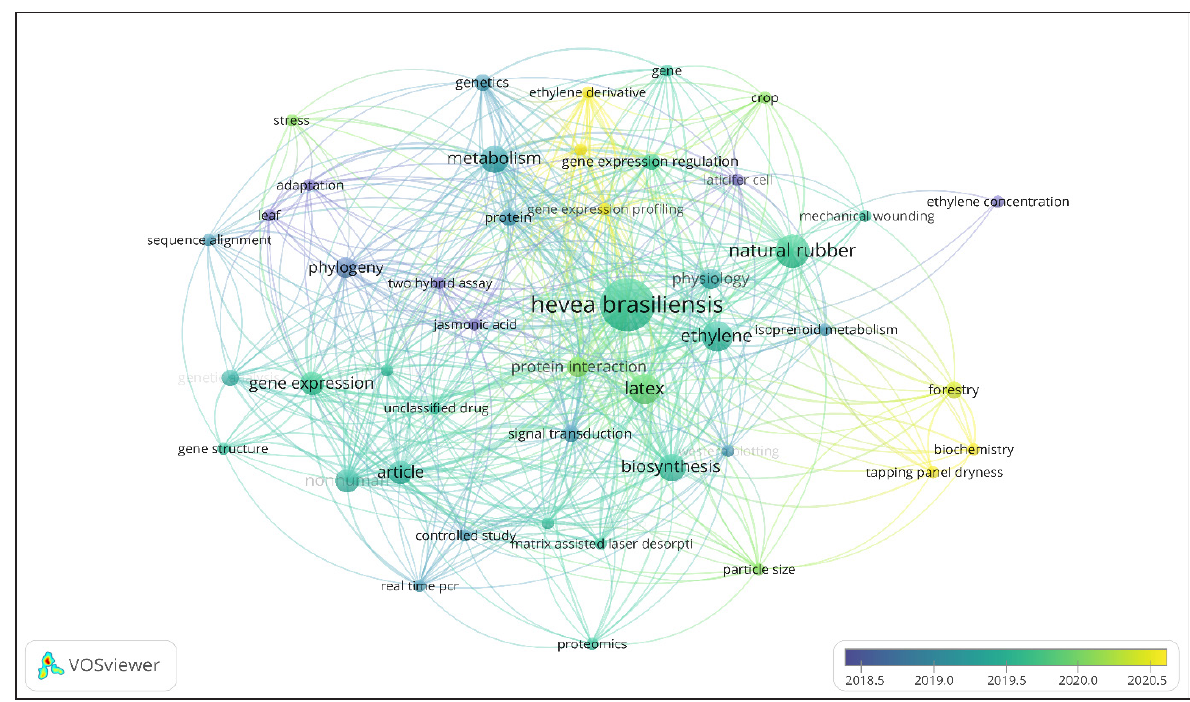
Figure 5. Overlay map of keywords related to oxidative stress due to harvesting practice using two minimum occurrences thresholds from 16 papers included in the analysis. The bigger circle indica- tes a higher frequency of appearance of the keyword. Lines show networks among